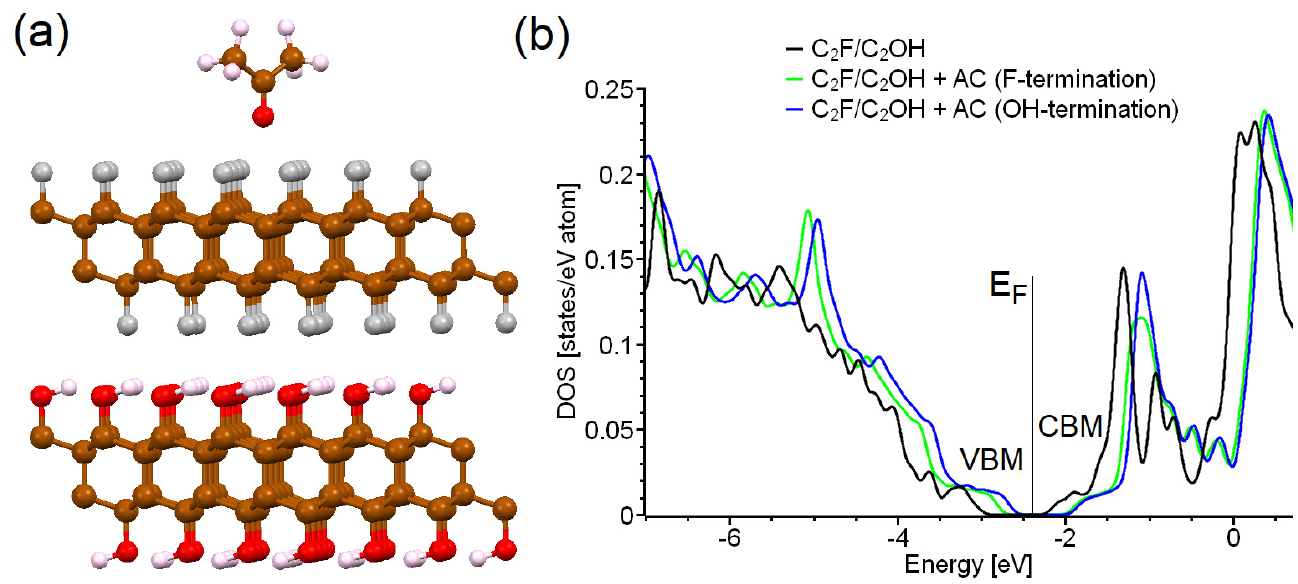
Figure 4. Side view of optimized atomic structure of C 2 F/C 2 OH single layer with acetone molecule physically adsorbed on F-terminated side ( a ), and total densities of states of the C 2 F/C 2 OH single layers before and after adsorption of acetone on different sides (terminations) ( b ). The color scale of the atoms in panel ( a ) is the same as in Figure 1.